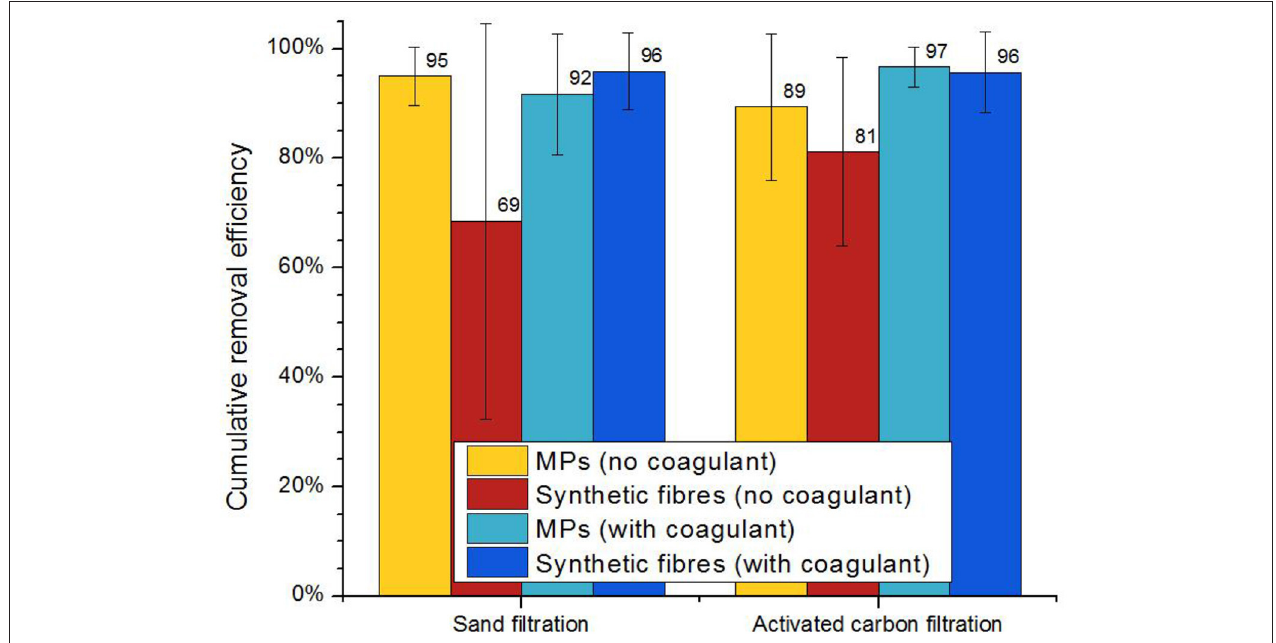
FIGURE 8 | Average MPs and synthetic fibres cumulative removal efficiency with their respective standard